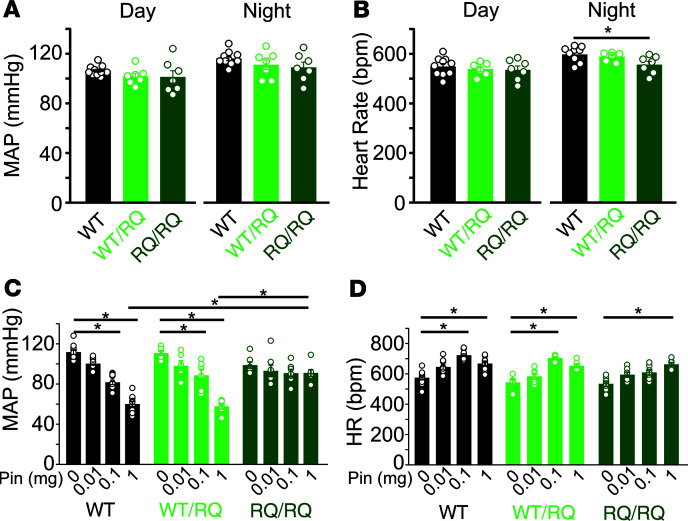
Cardiovascular function of R1154Q mice.(A) Mean arterial pressure (MAP) and (B) mean HR in conscious WT, heterozygous SUR2WT/RQ, and SUR2RQ/RQ mice during day and night. (C) MAP and (D) HR in anesthetized mice showing blunted response to the KATP channel activator pinacidil (Pin) in SUR2RQ/RQ mice. Statistical significance was determined by 1-way ANOVA followed by Tukey’s test for pairwise comparison; asterisks indicates significant difference (P < 0.05) within genotypes.